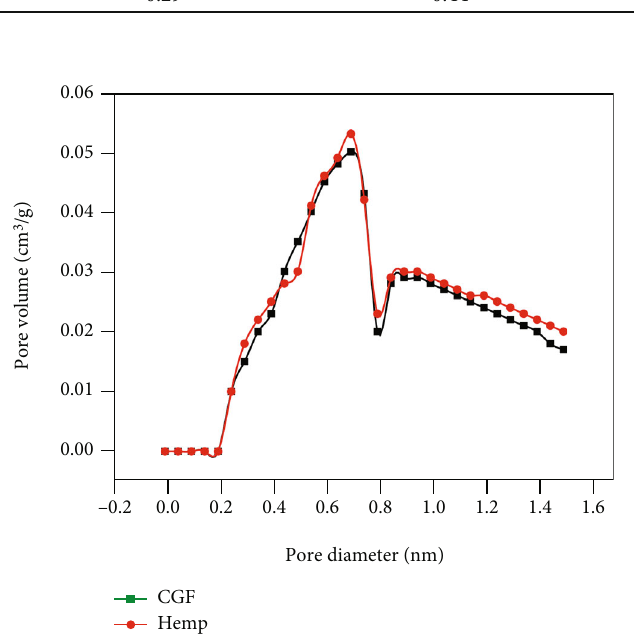
Figure 10: Micropore distribution of CGF and hemp activated carbon.